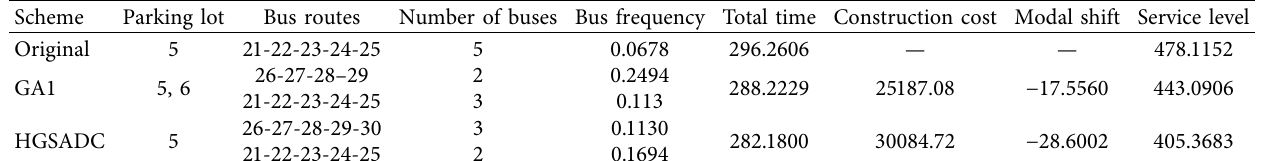
Table 7: Results of three schemes.